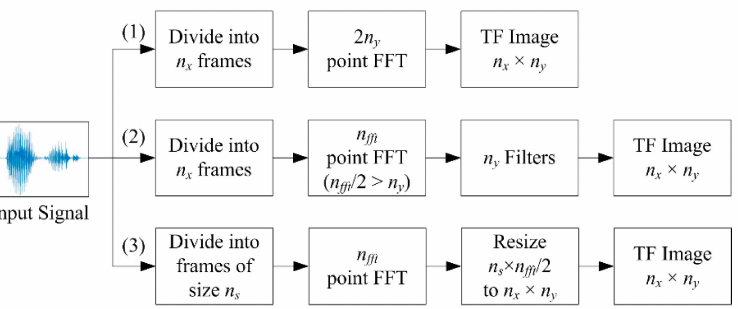
Figure 1. Overview of same sized time-frequency (TF) image formation